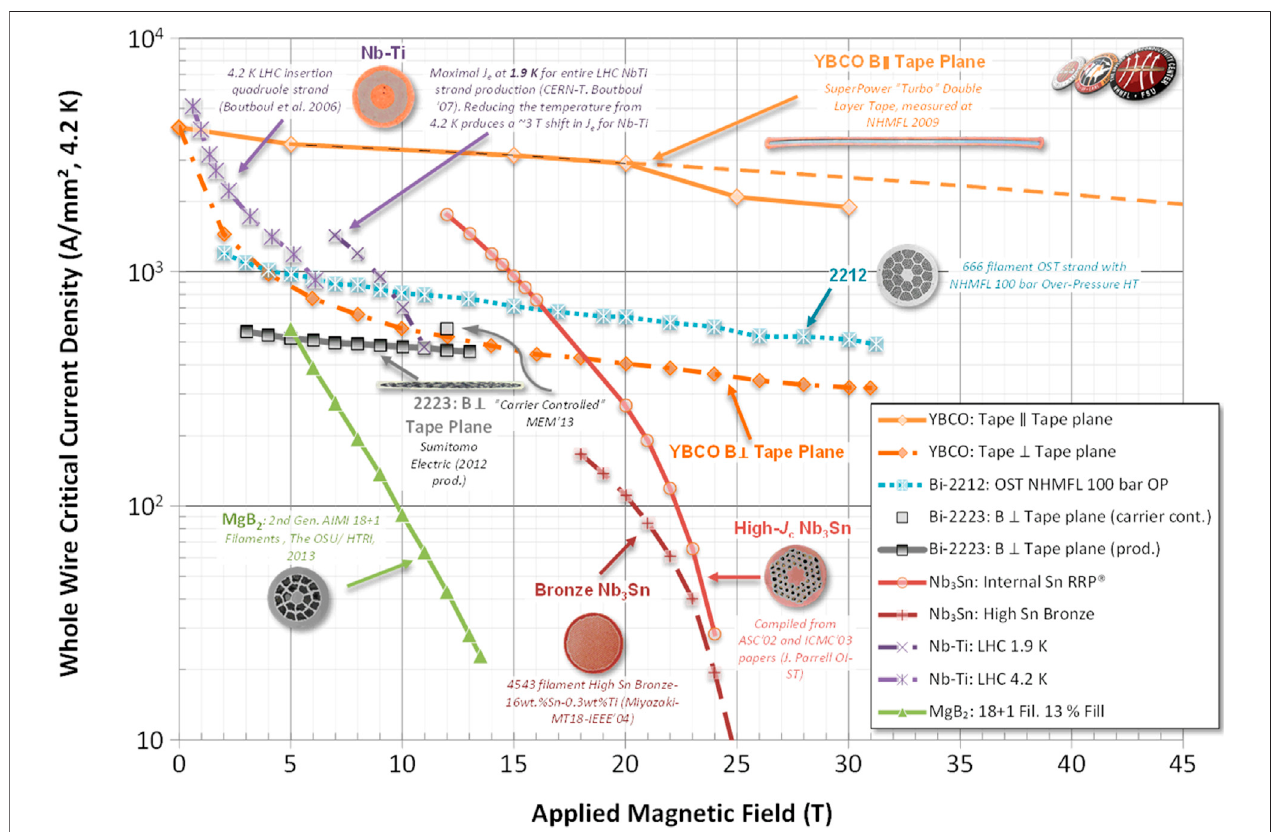
FIGURE8| Wholewirecriticalcurrentdensityofmainsuperconductorsat4.2 K[48],amongthemYBCO,BI-2212andBI-2223belongingtoHTSandNbTi,MgB 2 and Nb 3 Sn belonging to LTS.